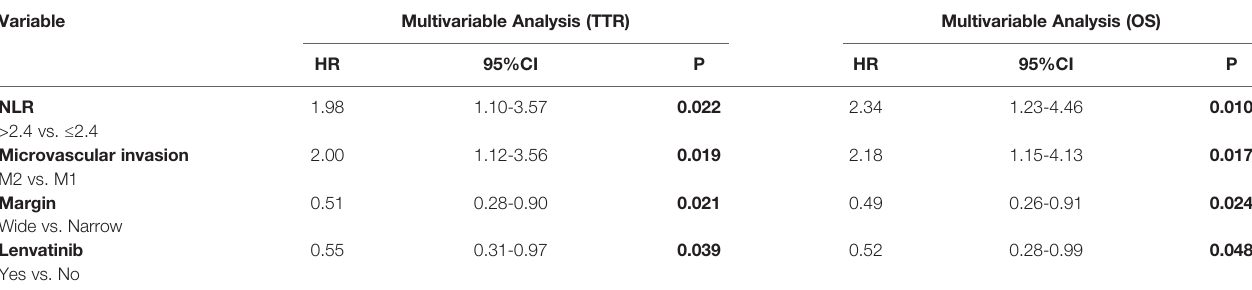
TABLE 7 | Multivariate Cox-regression analysis for predicting TTR and OS in 114 HCC patients with Microvascular Invasion with and without adjuvant Lenvatinib after PSM.